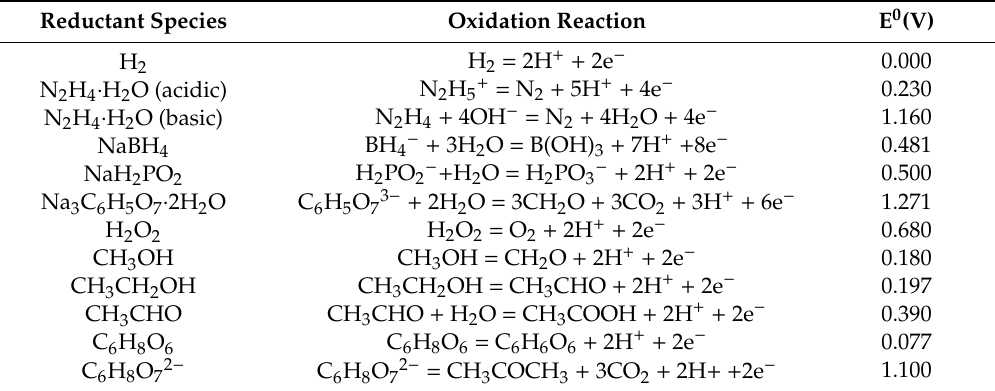
Table 2. Oxidation reactions with their corresponding E 0 of common